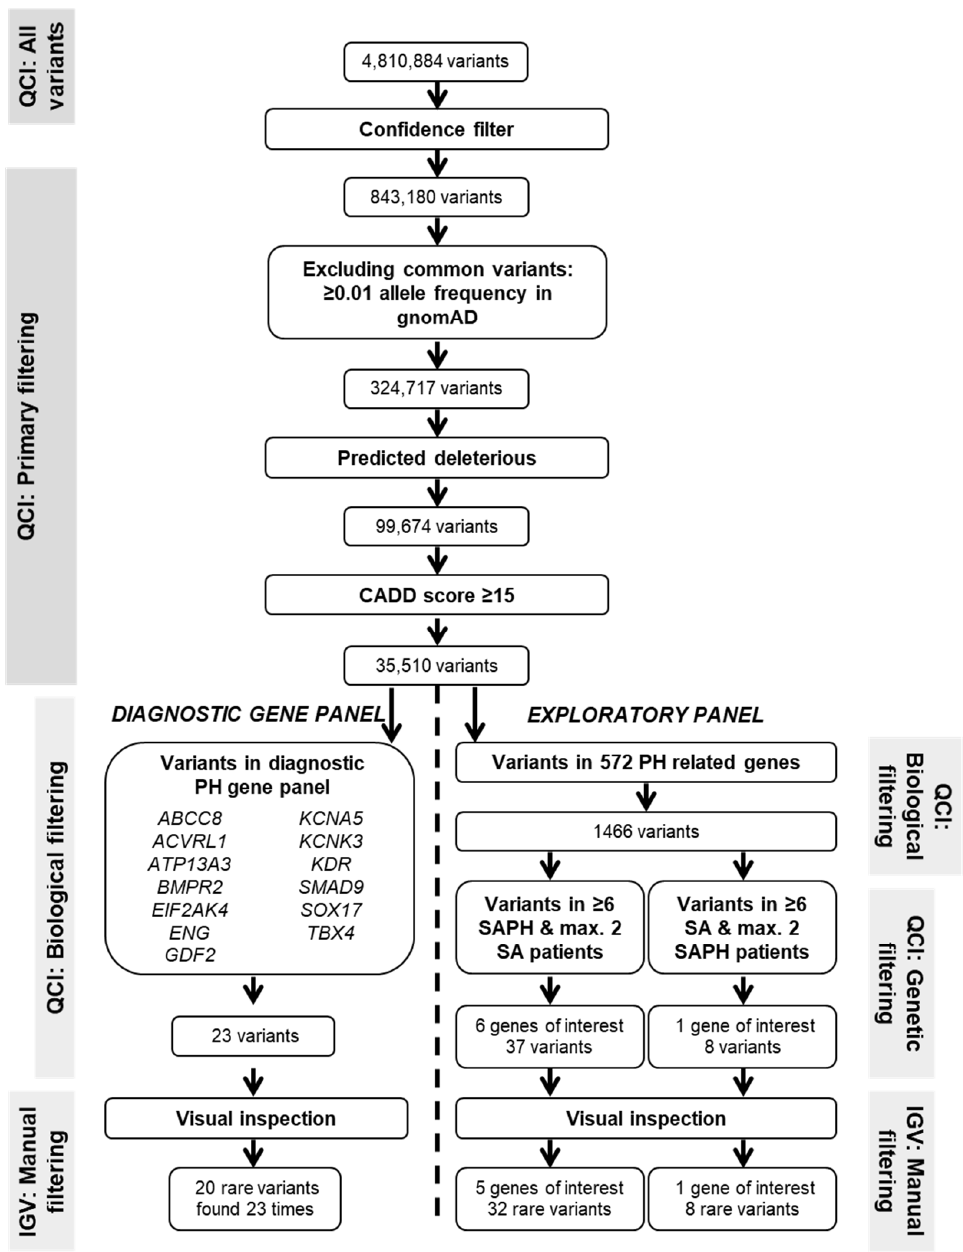
Figure 1. Filtering of the variants. The number of variants in the analysis after each filtering step. The first filtering steps were performed using the Qiagen Clinical Insight (QCI) software. The final step consisted of visual inspection of each variant using the Integrative Genomics Viewer (IGV) tool.